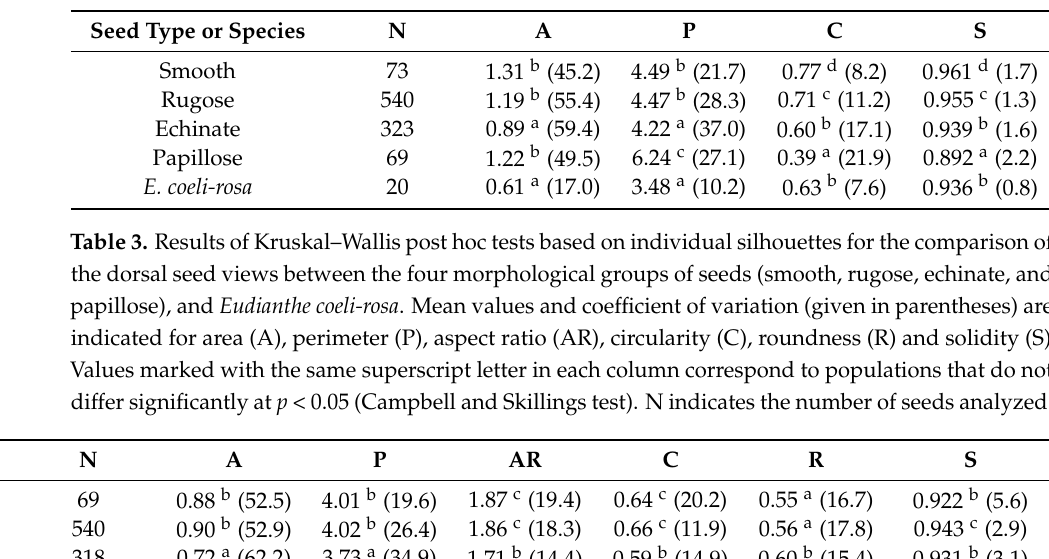
Table 2. Results of Kruskal–Wallis post hoc tests based on individual silhouettes for the comparison of the lateral views between the four morphological groups of seeds (smooth, rugose, echinate, and papillose) and Eudianthe coeli-rosa . Mean values and coefficient of variation (given in parentheses) are indicated for area (A), perimeter (P), circularity (C), and solidity (S). Values marked with the same superscript letter in each column correspond to populations that do not differ significantly at p < 0.05 (Campbell and Skillings test). N indicates the number of seeds analyzed.